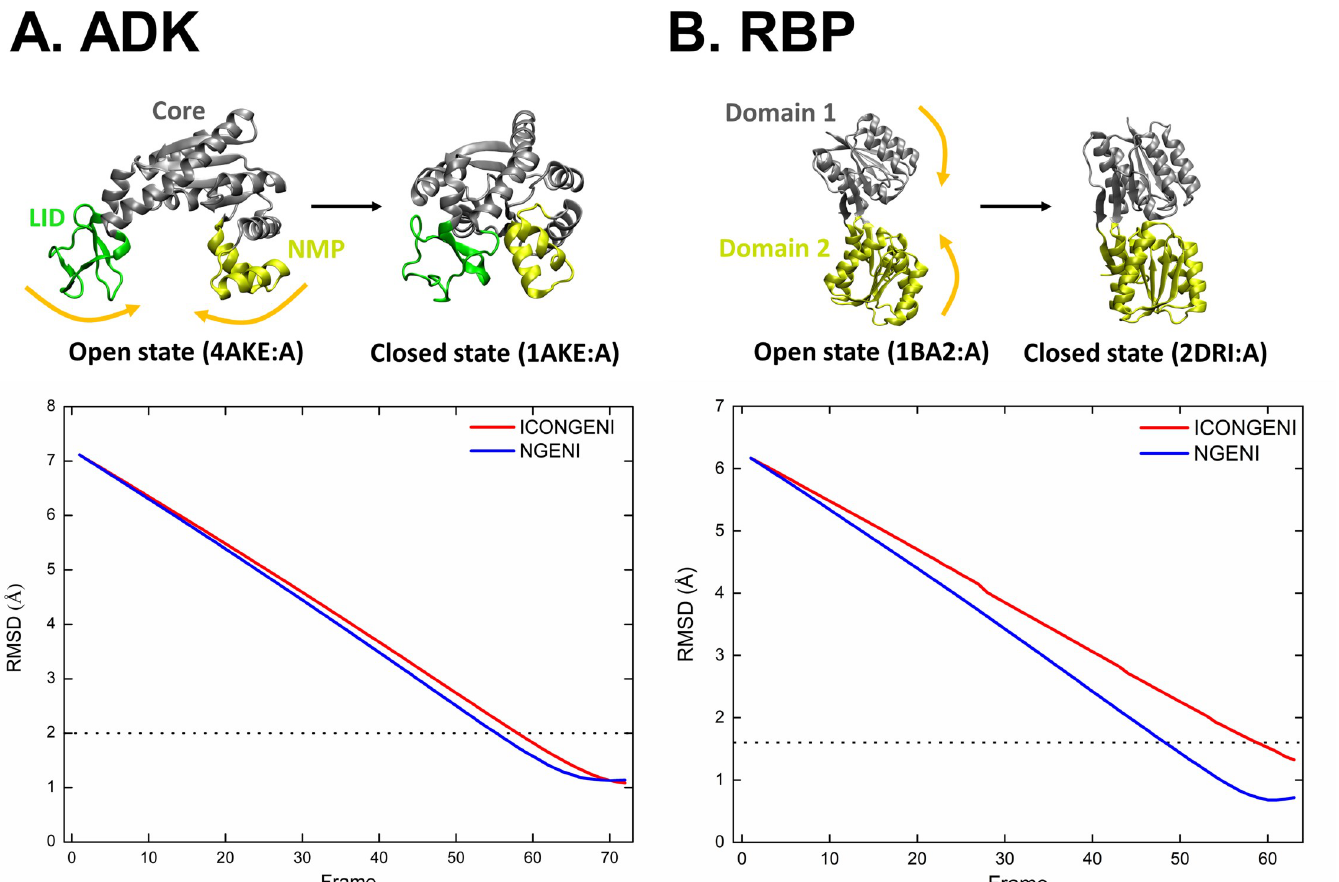
Fig 3. Conformational transition from open to closed states of (A) ADK and (B) RBP. Upper figures represent crystal structures of open and closed states of the proteins. ADK is composed of three domains: CORE (residues 1–29, 60–121, and 160–214), NMP (residues 30–59), and LID (residues 122–159). RBP is composed of Domain 1 (residues 1–103 and 236–264) and Domain 2 (residues 104–235 and 265–271). The lower graphs describe the convergence of simulated pathways of each protein by measuring changes in RMSD between predicted intermediates and the final structure. The results of ICONGENI and NGENI pathways are shown as red and blue lines, respectively. The black dotted lines represent the corresponding experimental resolution of the